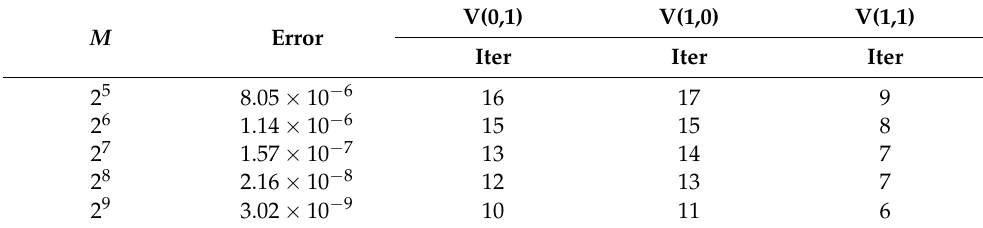
Table 4. L 2 errors for (72) with ω = 0.5 by the third-order